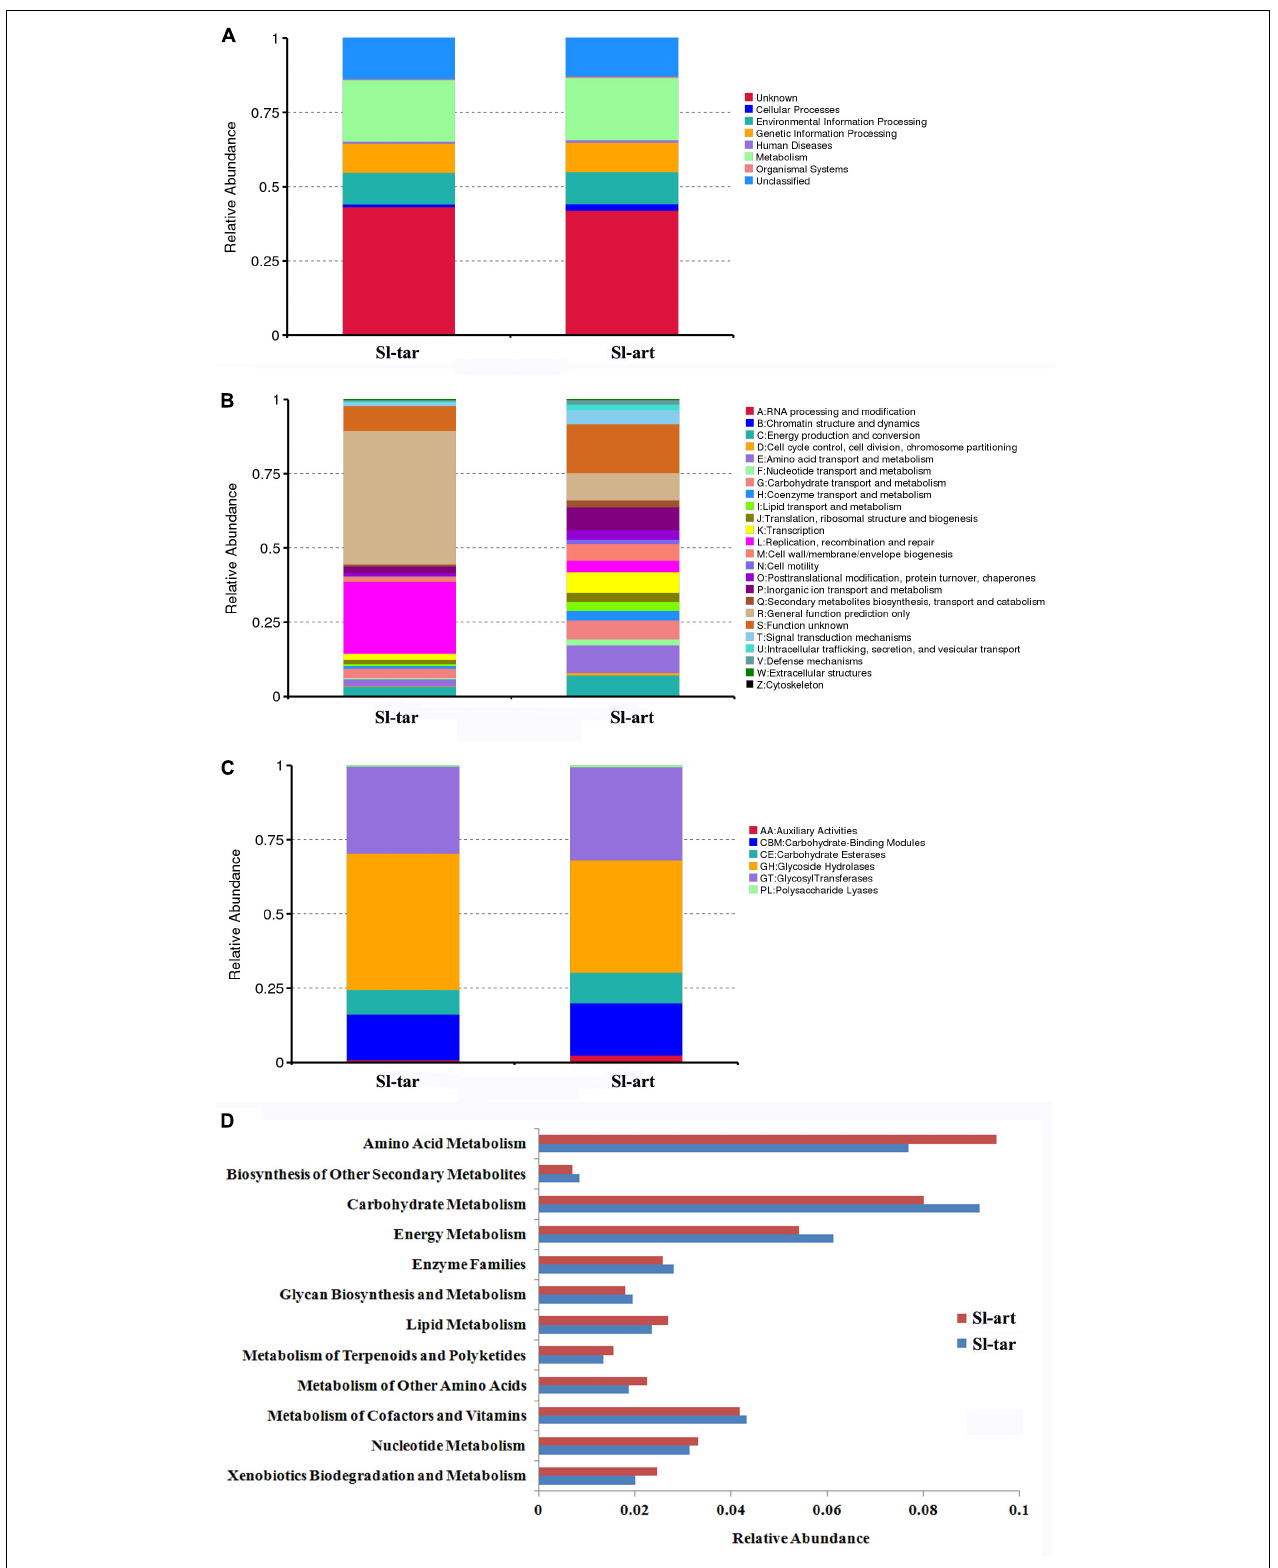
FIGURE 4 | Metagenomic analysis of gut microbes in S. litura . (A) KEGG analysis of S. litura gut microbes, (B) eggNOG analysis of S. litura gut microbes, (C) CAZy analysis of S. litura gut microbes, (D) KEGG metabolic functions of the S. litura gut microbes.